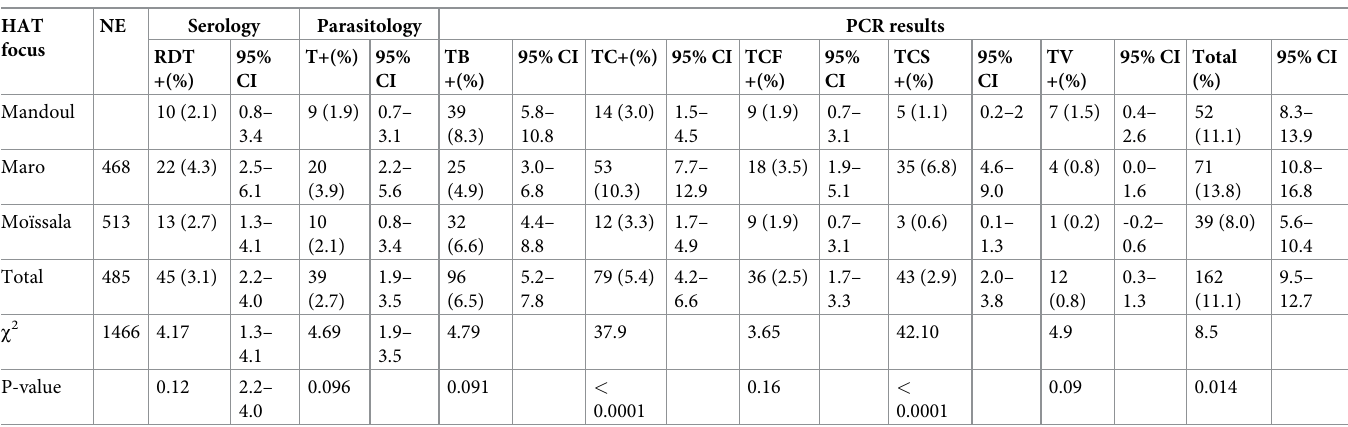
Table 1. Prevalence of trypanosome species according to HAT foci.